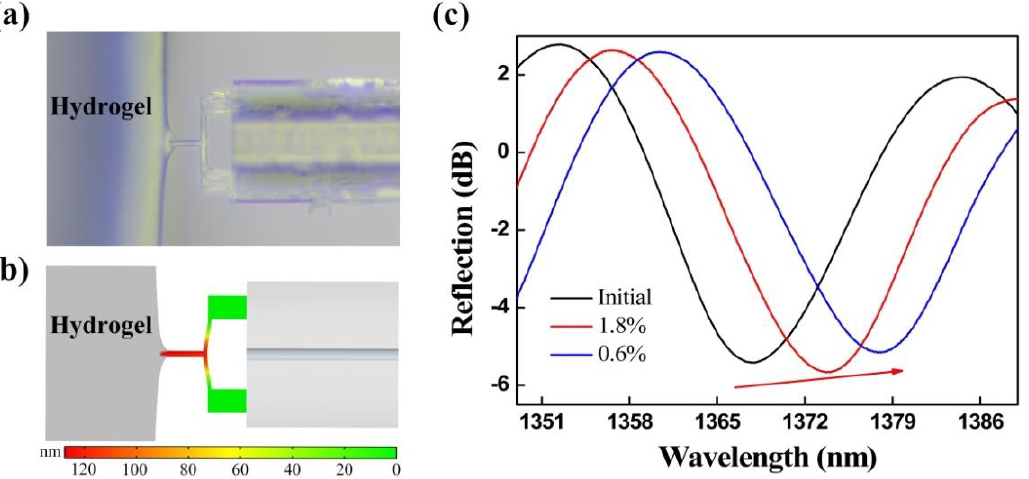
Figure 5. ( a ) Probe of the FTMS was encapsulated by micro-protrusions of the hydrogel under the effect of the adhesion force. ( b ) Simulation results for adhesion of the FTMS to agarose hydrogels. ( c ) Evolution of the reflection spectrum under the action of the adhesion.